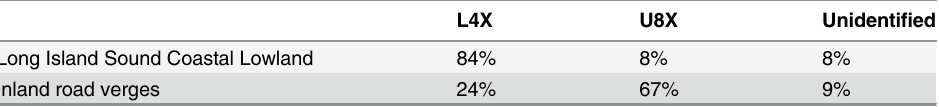
Table 4. Percentage of switchgrass ecotypes in coastal or inland